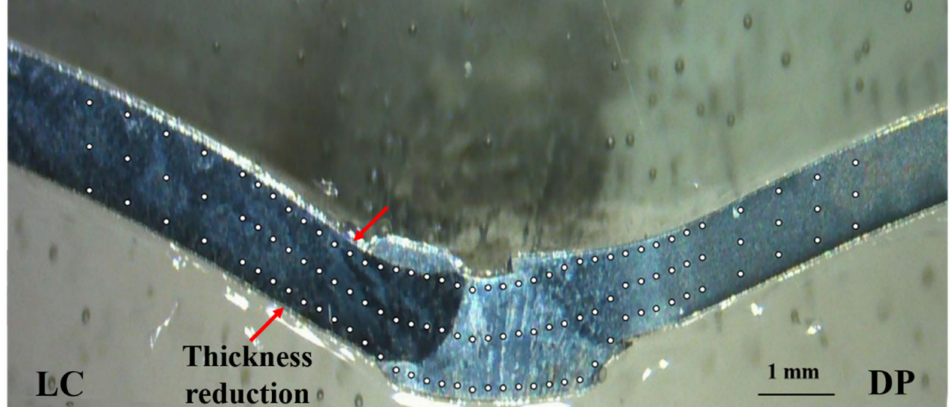
Figure 16. Front view of the dissimilar welding after impact